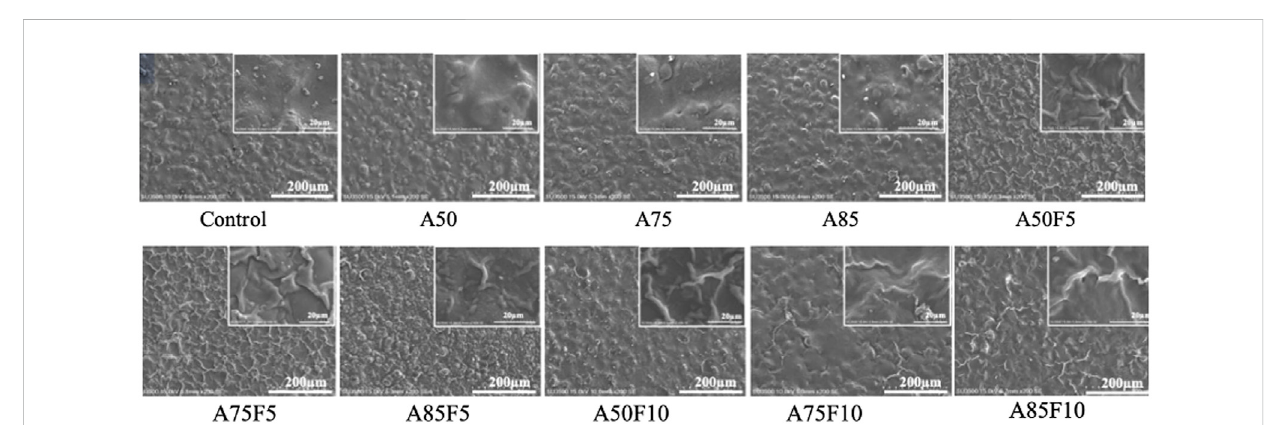
FIGURE 3 Scanning electron microscopy (SEM) images showing rough granular surfaces on allylamine treated samples and irregular folding proteins on the fi bronectin modi fi ed surfaces.